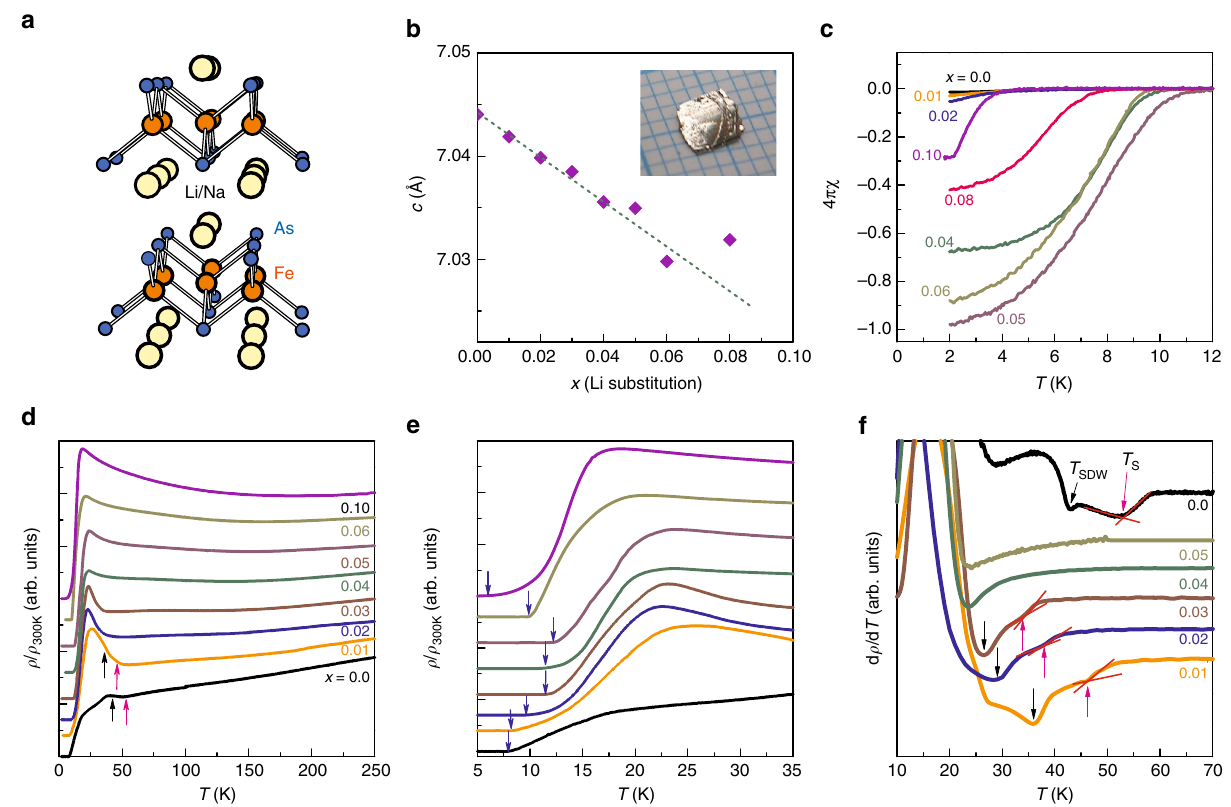
Fig. 1 Characterization of the Na 1 − x Li x FeAs single crystals. a Crystal structure of Na 1 − x Li x FeAs. b Variation of the c -axis lattice parameter of the Na 1 − x Li x FeAs single crystals at 300 K with a linear dashed guide line. Inset shows the ab -plane image of a single crystal in a millimeter scale. c Zero- fi eld cooled magnetizations at low temperatures at H ab = 10 Oe, revealing SC transition and shielding fractions. d – f Temperature dependence of normalized resistivity, ρ / ρ 300K , enlarged resistivity near the SC transition, and d ρ /d T for selected samples. Black and magenta arrows in d , f denote SDW ( T SDW ) and structural ( T S ) transitions, respectively, while blue arrows in e re fl ect the T ρ c evolution with x . Note that although previous studies of NaFeAs have observed a local in fl ection point in the ρ curve at T SDW (or a sharp dip in d ρ /d T ), we observed weak minimum for our NaFeAs due to the presence of